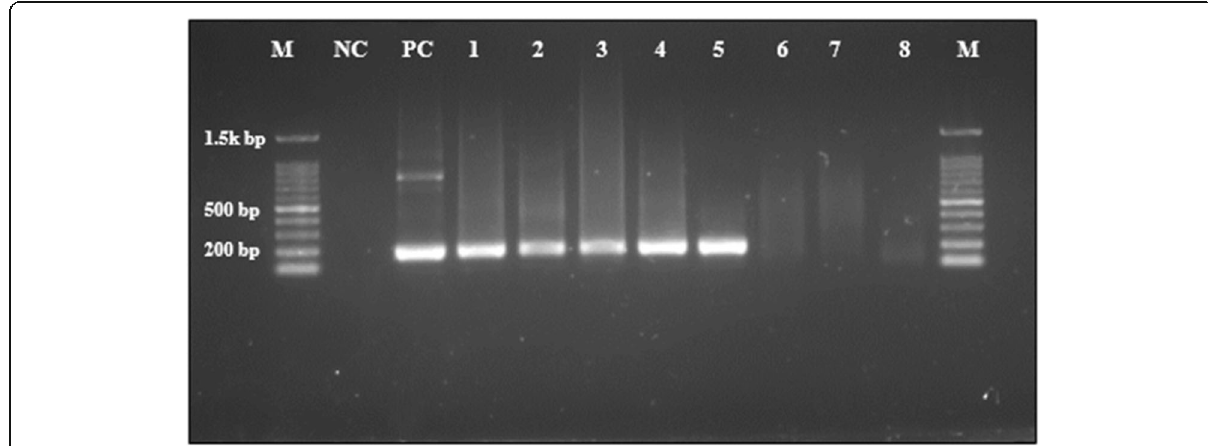
Fig. 1 DNA amplification of Plasmodium species by nPCR. Lane M: 100 bp DNA Marker. Lane NC: negative control. Lane PC: positive control. Lane 1 – 5: positive samples for P. falciparum t. Lane 6 – 8: negative